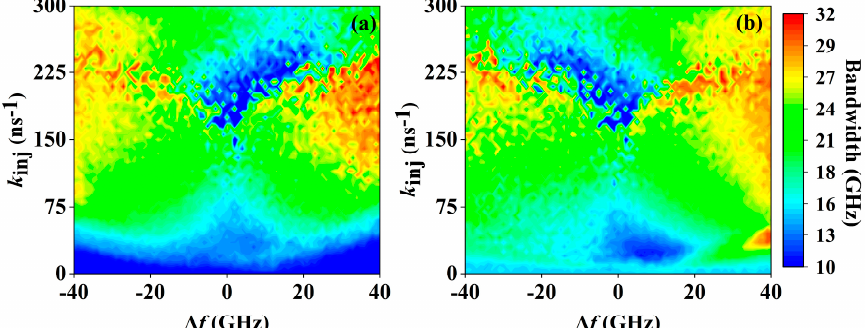
Figure 9. Polarization chaos bandwidth of ( a ) XP mode and ( b ) YP mode of VCSEL1 in orthogonal injection as a function of the coupling coefficient k inj and frequency detuning Δ f . injection as a function of the coupling coefficient k